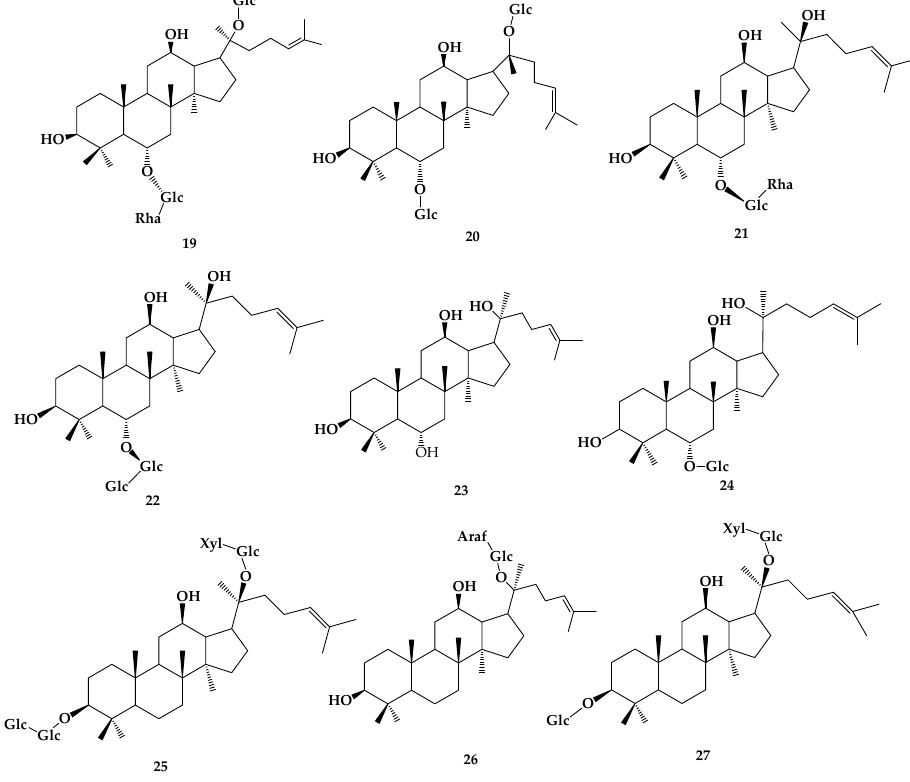
Figure 5. The chemical structures of compound 19–27